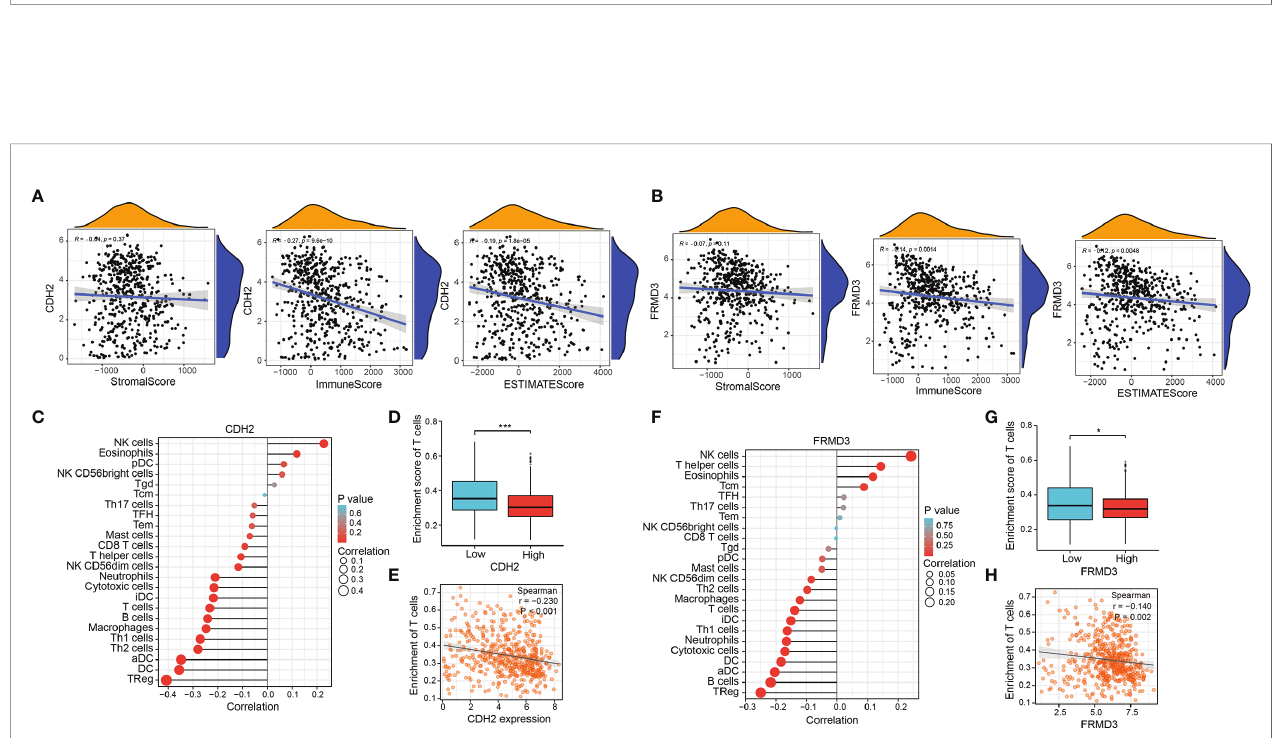
FIGURE 6 | The functions and pathways associated with CDH2 and FRMD3. The Gene ontology (GO) and KEEG analysis were performed by the functions associated with CDH2 (A) and FRMD3 (B) .